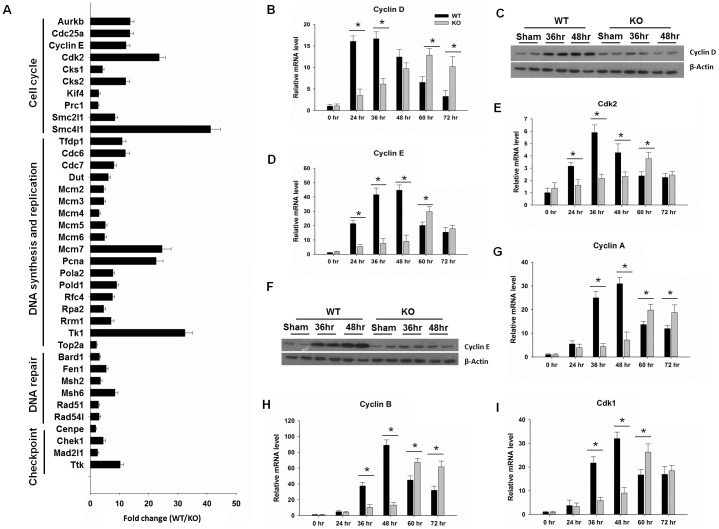
Depressed E2f downstream target gene expression in PPARβ-null (KO) mice after PH.(A) qPCR analysis of E2f target gene involved in cell cycle, DNA synthesis and replication, and DNA repair. (B) Real time qPCR analysis of Cyclin D over a time course from 0 to 72 hours after PH. (C) Western blot analysis of Cyclin D at 36–48 hr after PH. Real time qPCR analysis of (D-E) Cyclin E/Cdk2, and (G-H) Cyclin A, B/Cdk1 in wild-type (WT) and KO mice over a time course from 0 to 72 hours after PH. (I) Western blot analysis of Cyclin E at 36–48 hr after PH (n = 3). Means ± SD are graphed. * p<0.05.